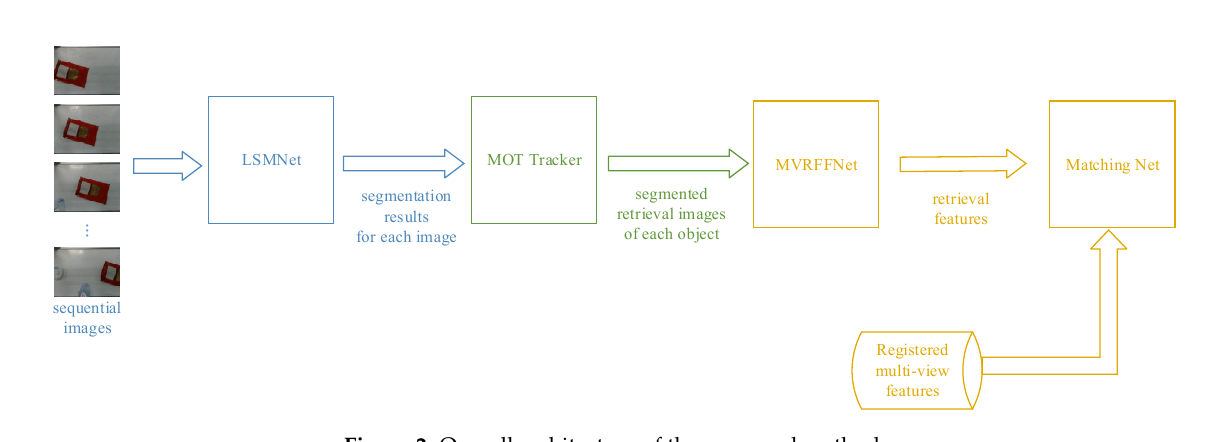
Figure 2. Overall architecture of the proposed method.